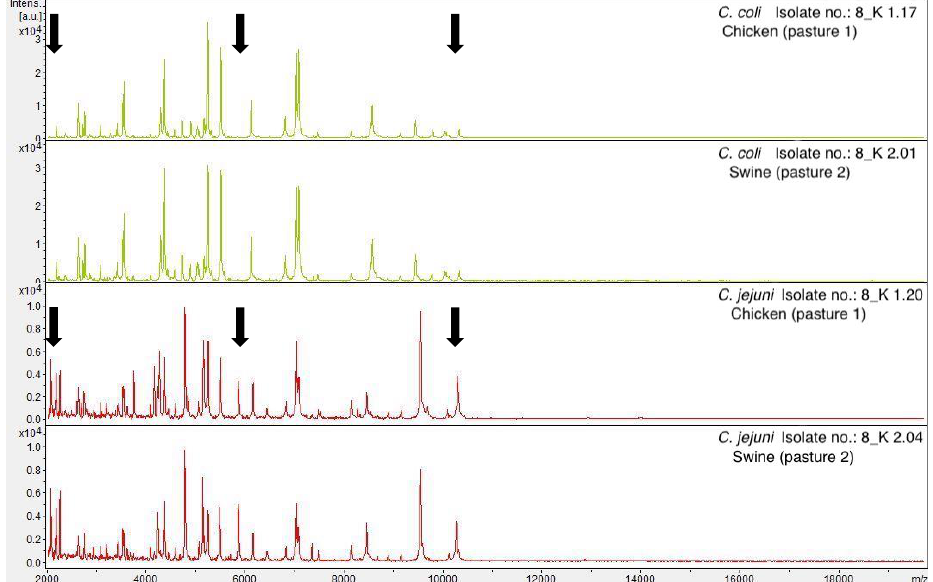
Figure 3. Examples of MALDI-TOF MS mass spectra of C. coli and C. jejuni isolated from chickens and pigs. Arrows indicate peaks that are absent or present in both species.